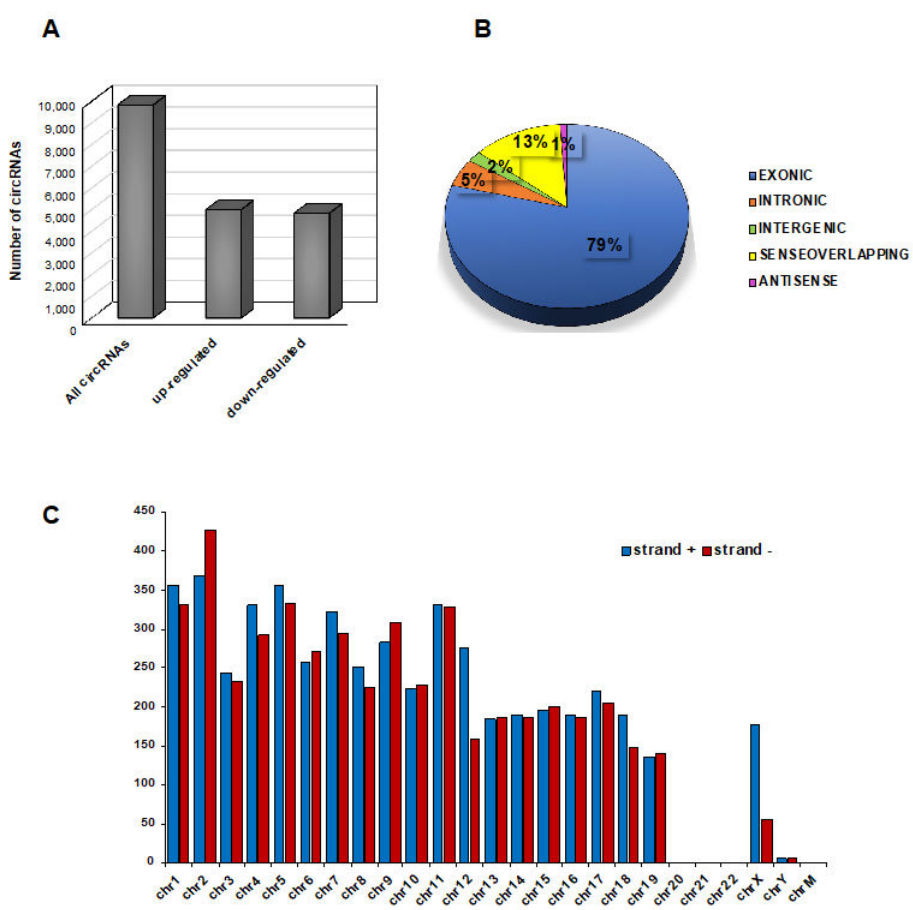
Figure 2. Overview of circRNA expression in mouse SPZ. ( A ) The distribution of up- and down- regulated circRNAs in HFD (n = 3) compared with CTRL (n = 3) SPZ among a total of 9838 circRNAs. ( B ) The proportion of different types of circRNAs among all predicted circRNAs. ( C ) Chromosomal distribution of SPZ-derived circRNAs on strand + and strand –, according to their host gene